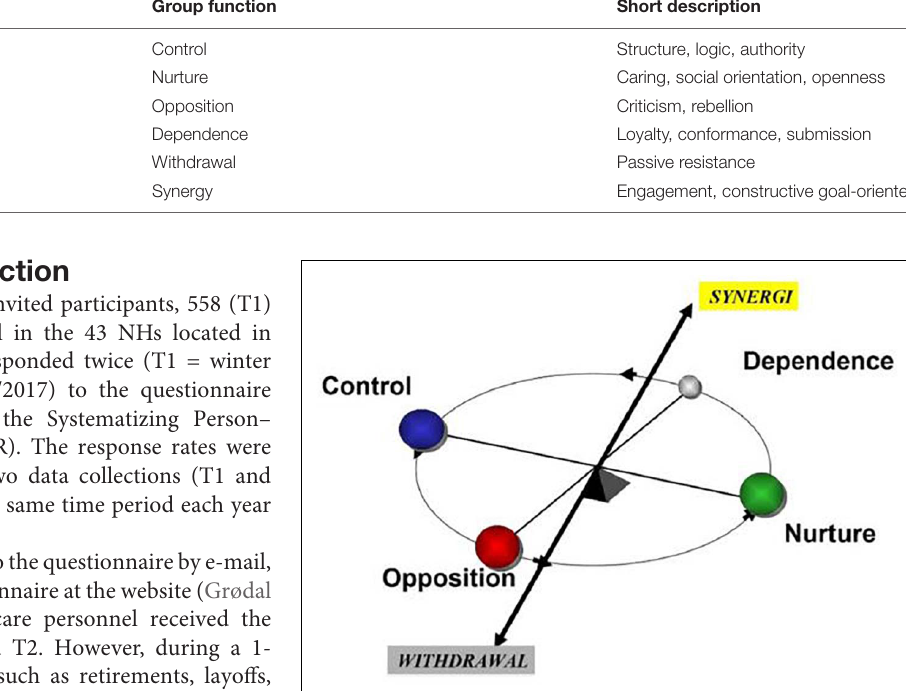
TABLE 1 | Elements of group constitution based on the Systematizing Person–Group Relations instrument. Dimension/vectors